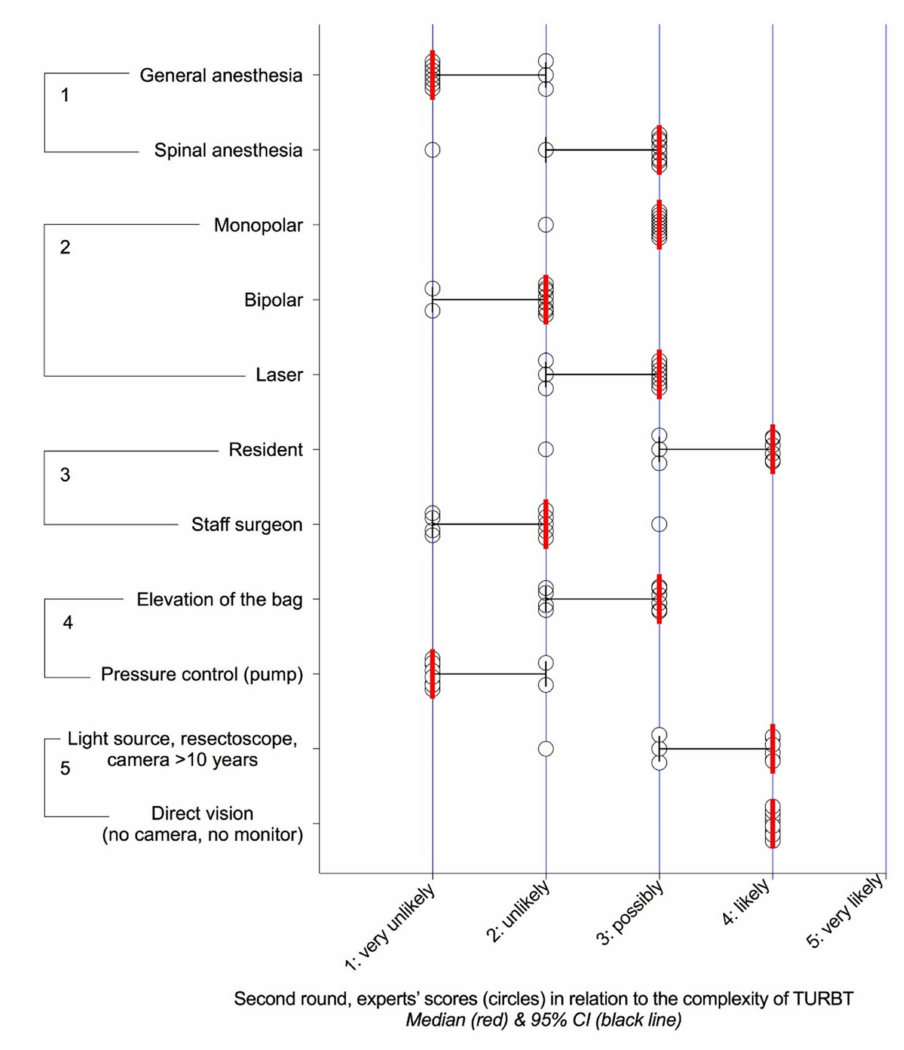
Figure 4. Distribution of the scores regarding the likelihood of incomplete resection and / or prolonged surgery ( > 1 h) and / or significant (Clavien-Dindo ≥ 3) perioperative complications according to the surgical environment: ((1) anaesthesia, (2) energy, (3) operator, (4) bladder irrigation, (5)